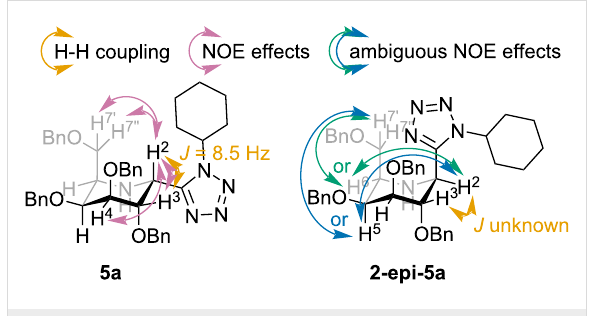
Figure 3: Proposed structures of compounds 5a and 2-epi-5a with 1 H- 1 H couplings and NOE e ff ects